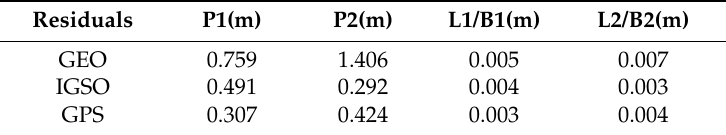
Table 3. RMS of residuals of codes (P1 and P2) and phases (GPS: L1 and L2, BDS: B1 and B2) of GEO, IGSO,